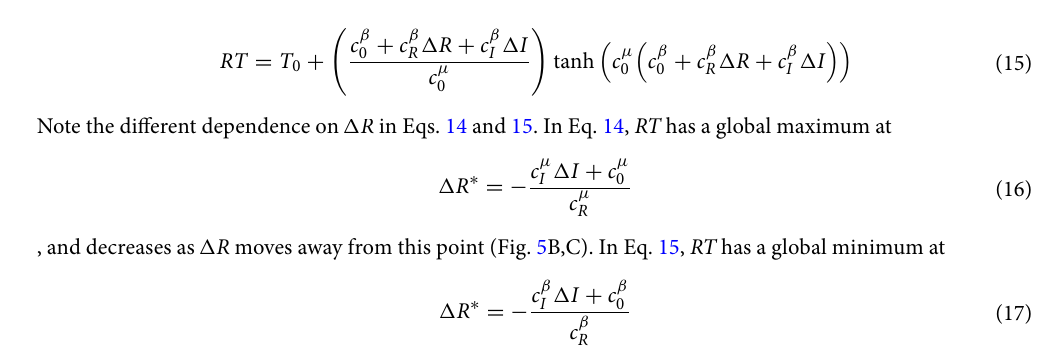
β = c β = 0 , R I µ = c µ = 0 , there is a R I